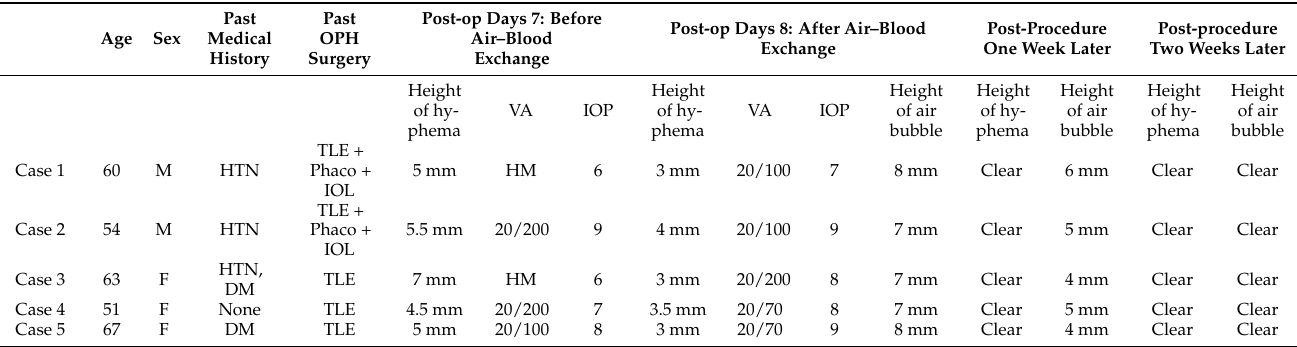
Table 3. Cases with hyphema treated by a novel air–blood exchange procedure using 12% perfluoropropane following